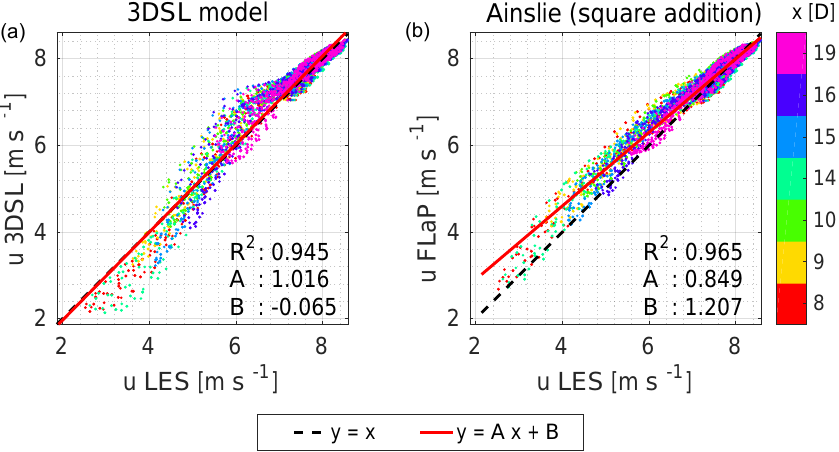
Figure 8. Test case 2 (multiple aligned wakes). Scatter plot and corresponding regression line of the wind speed derived from the 3DSL model (a) and from the FLaP wake simulations in relation to the reference wind field calculated with large-eddy simulations (LESs).